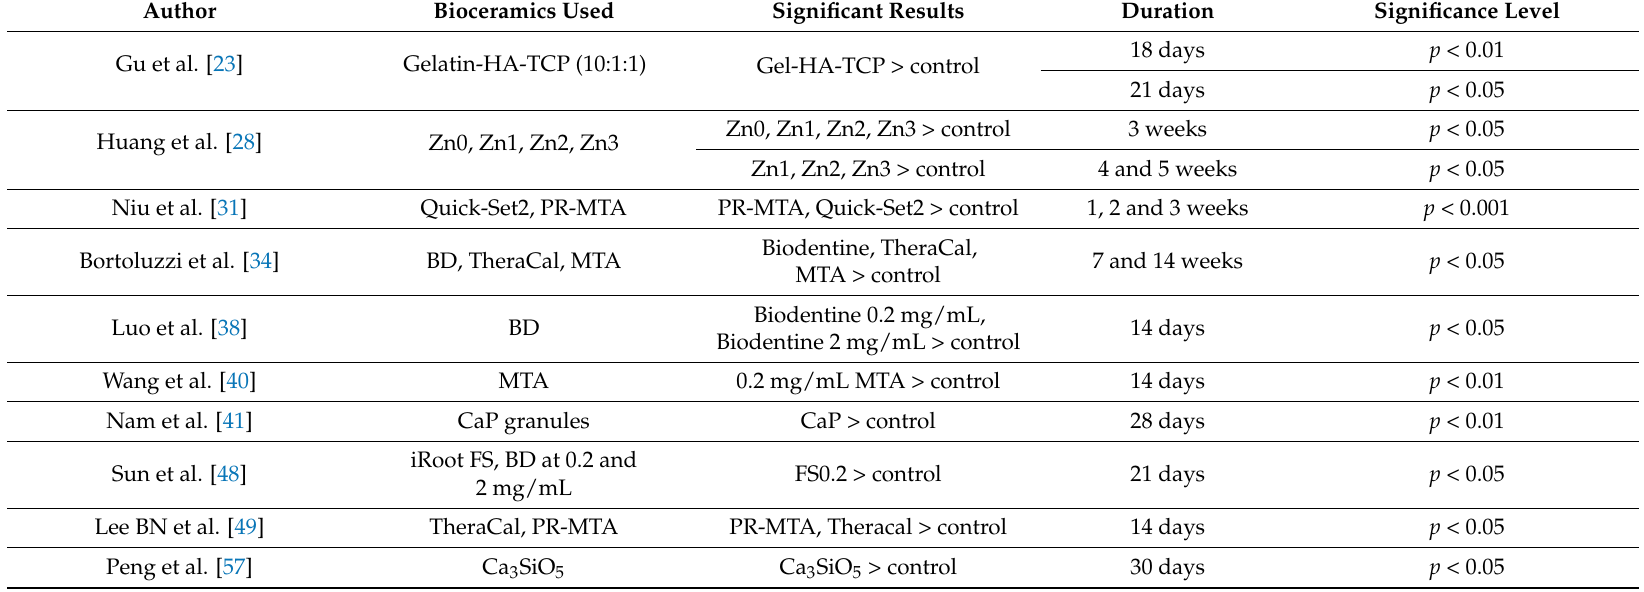
Table 13. Summary of the results of included studies showing significant differences between a bioceramic material and a control for ARS